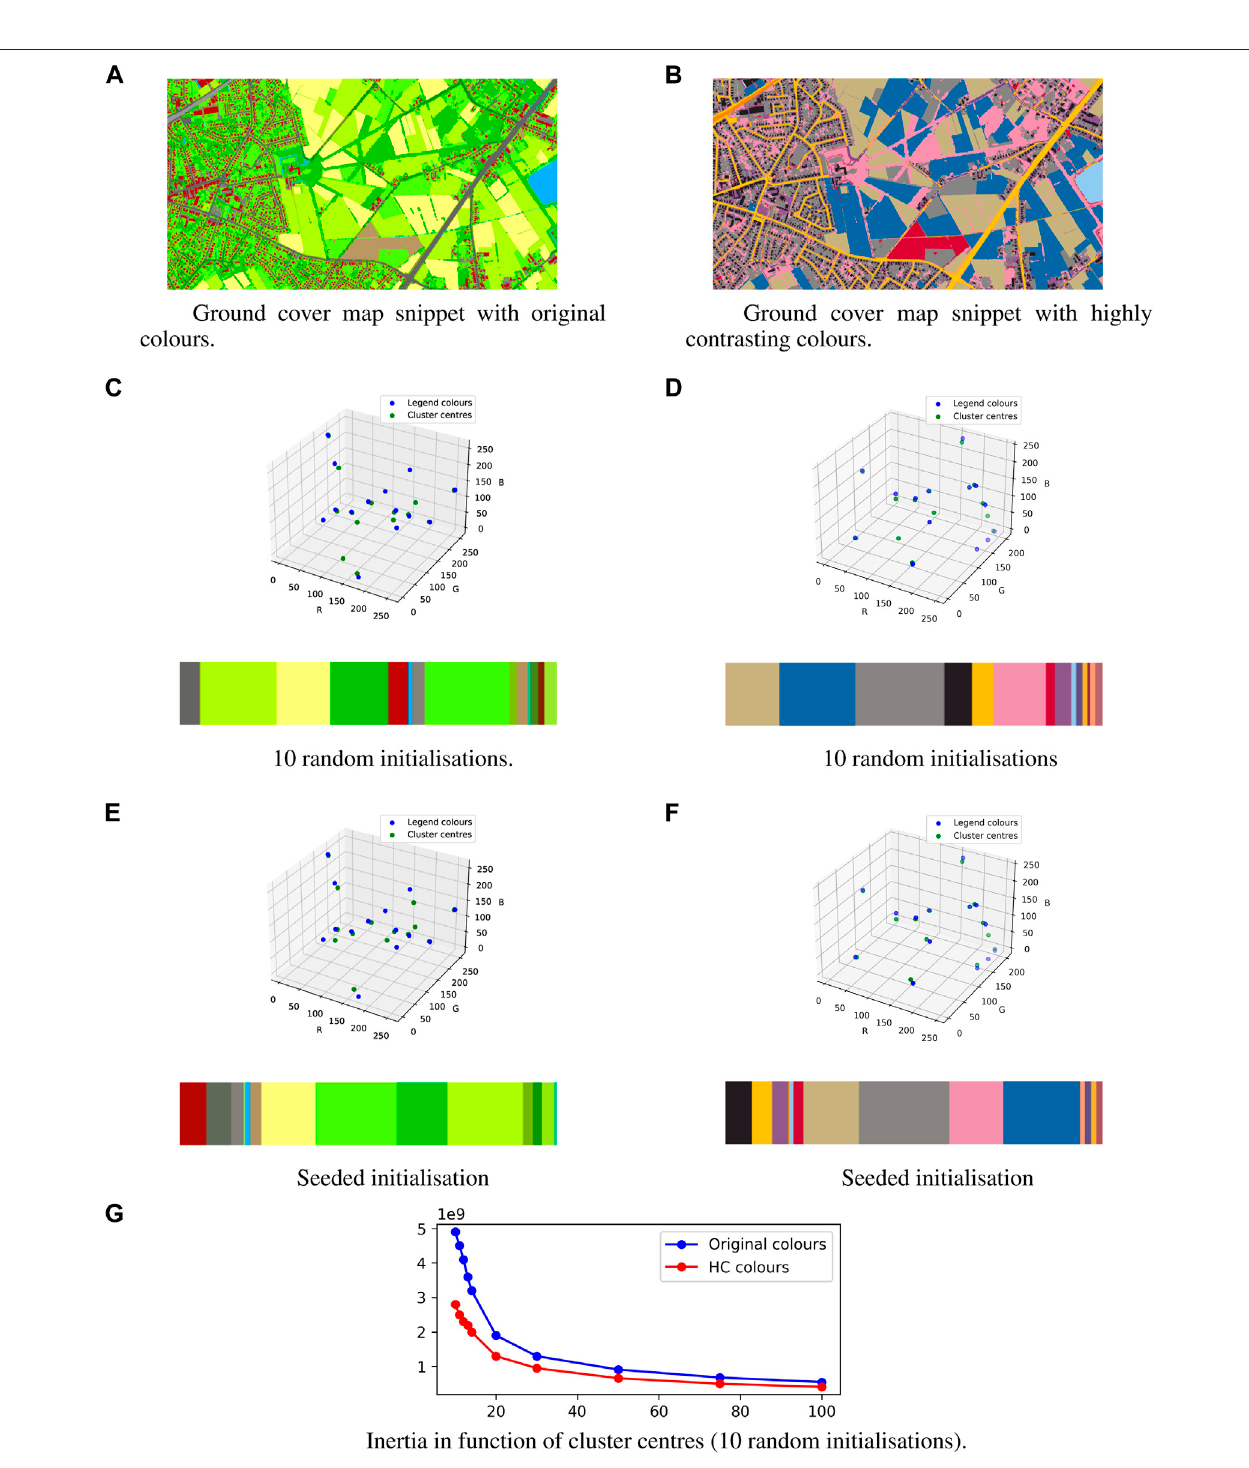
FIGURE11| Effectoftheemploymentofhighlycontrastingcoloursonthecolourclusteringmethodusingthek-means. (A) Groundcovermapsnippetwithoriginal colours, (B) Ground cover map snippet with highly contrasting colour (C) 10 random initialisations (D) 10 random initialisations (E) Seeded initialisation (F) Seeded initialisation (G) Inertia in function of cluster centres (10 random initialisations).